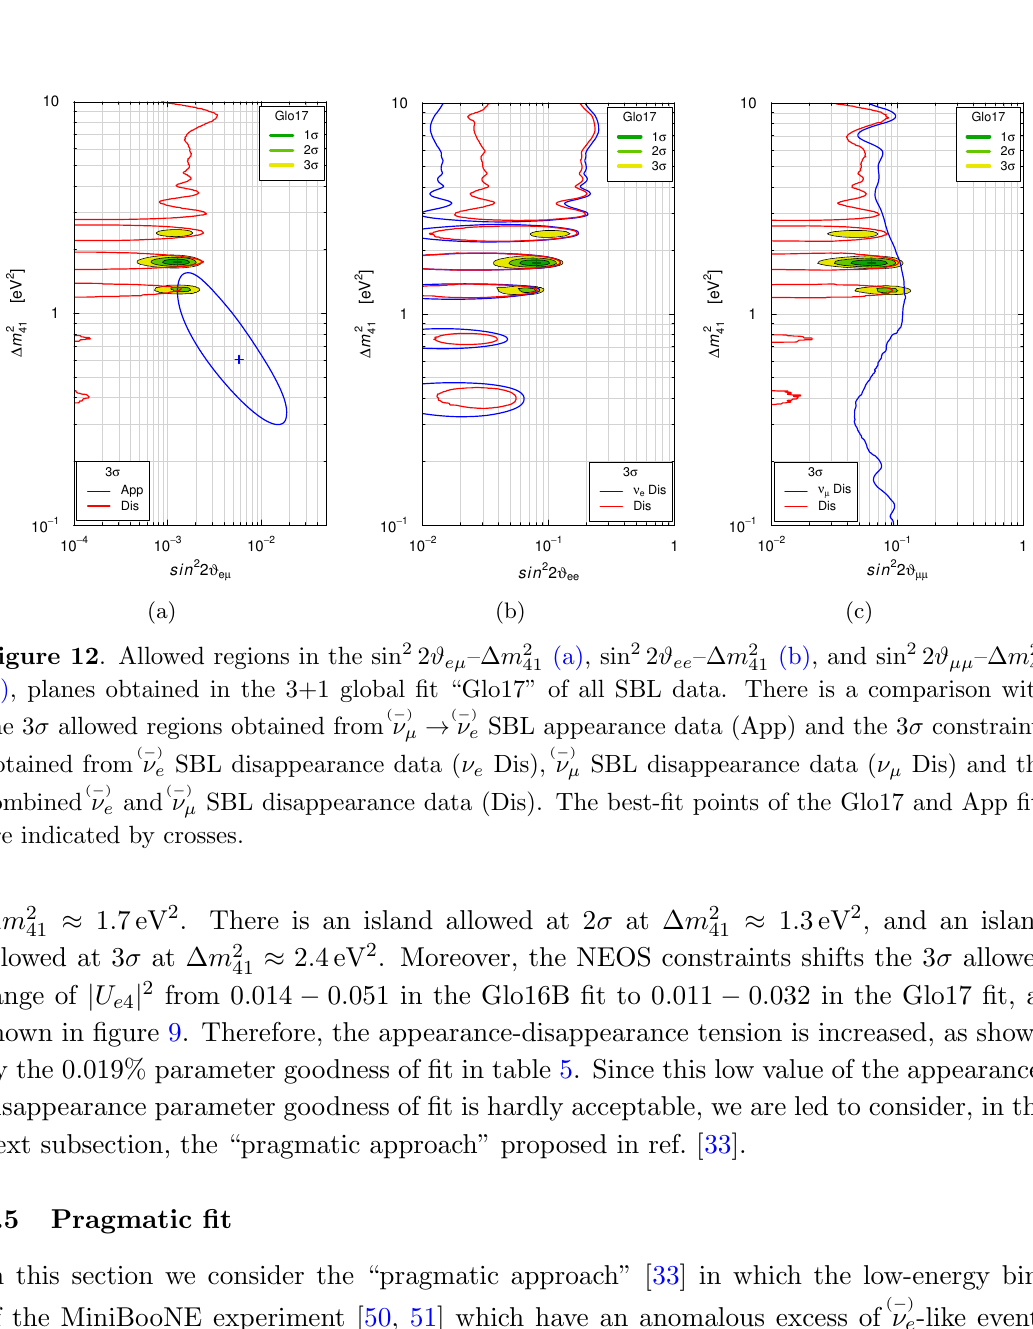
(a), sin 2 2 # ee {(cid:1) m 2 (b), and sin 2 2 # (cid:22)(cid:22) {(cid:1) m 2 41 41 41